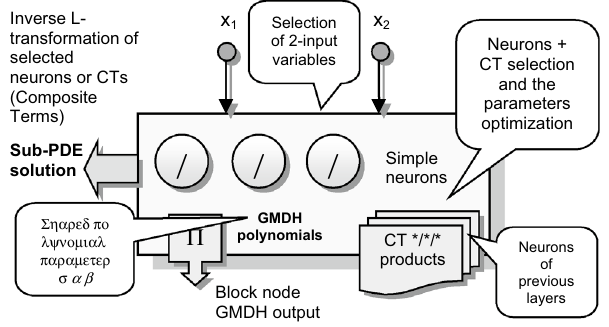
Figure 3. Node blocks form and convert specific 2-variable